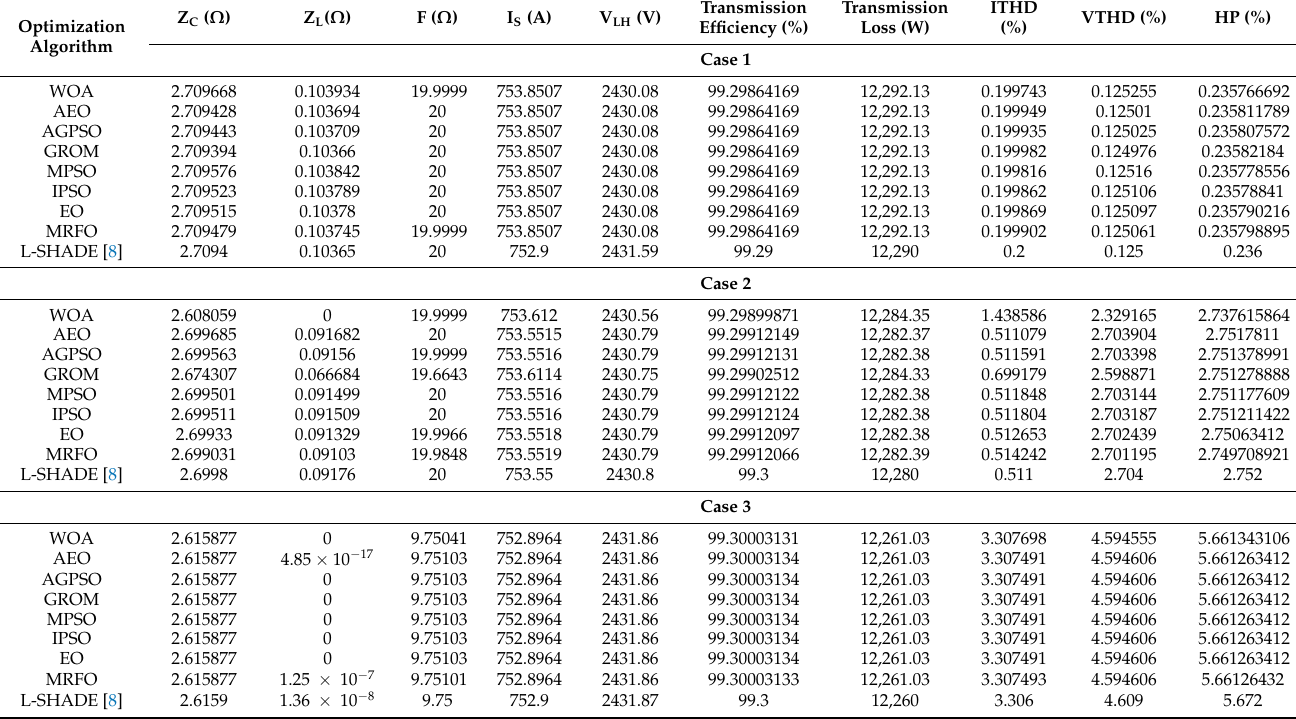
Table 4. The results of optimization algorithms for configuration 1 of the HAPF system over the three different cases.